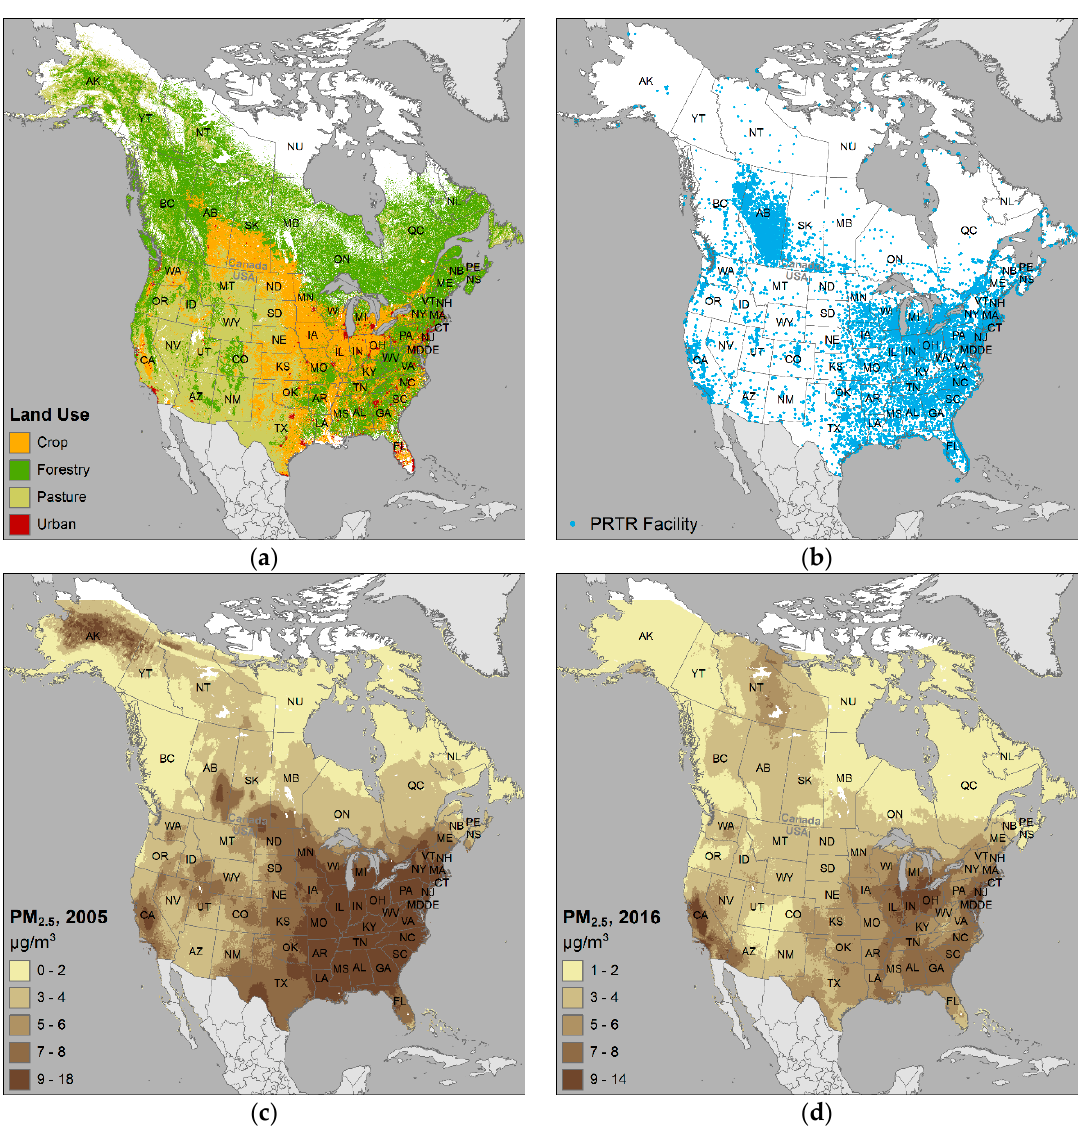
Figure 10. Selected environmental variables of interest in the SGA/LBW studies for Canada and USA of: ( a ) land use classes; ( b ) industrial facilities in pollutant release transfer reporting (PRTR); ( c ) common air pollutant – particulate matter particles with aerodynamic diameter ≤ 2.5 μ m, (PM ₂ . ₅ ) for 2005; and ( d ) PM ₂ . ₅ for 2016.